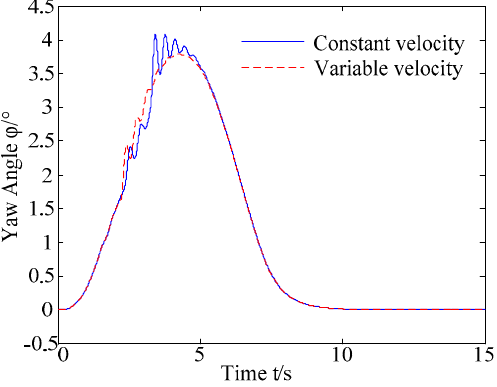
Figure 29. Front wheel angle of vehicle p under different velocities of vehicle q .